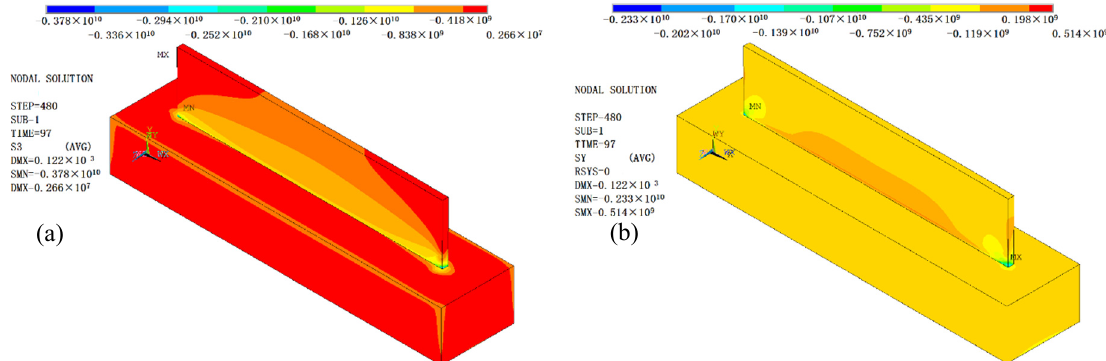
Figure 22. ( a ) The third principal stress contours after side milling of thin-walled parts; and ( b ) Y component normal stress contour after side milling of thin-walled parts.